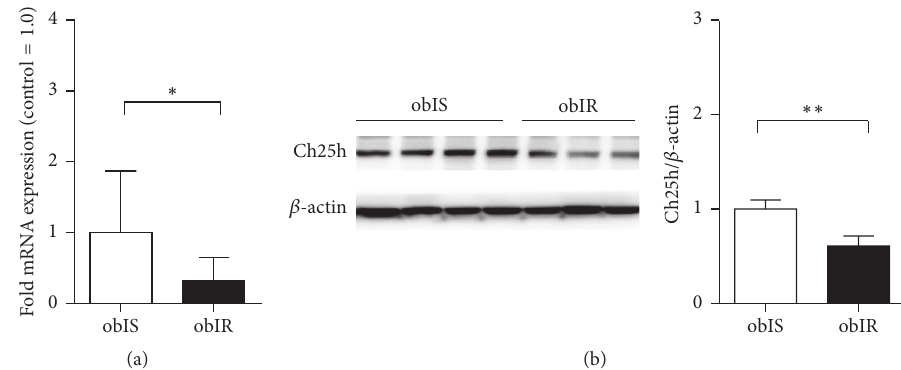
Figure 3: Obese IS mice show higher hepatic Ch25h levels than obese IR mice. (a) Relative Ch25h levels in isolated livers obtained from obese IR and obese IS C57BL/6J mice after 16 weeks on HFD. mRNA levels of hepatic Ch25h levels in obese IS mice were significantly higher comparing to obese IS mice. ∗ 𝑝 = 0.020 , 𝑛 = 5 per group. (b) Immunoblot analysis of Ch25h protein in isolated livers obtained from obese IR and obese IS C57BL/6J mice after 16 weeks on HFD. For immunoblot 𝛽 -actin was used as a loading control. ∗∗ 𝑝 = 0.002 , 𝑛 = 3 - 4 per group.